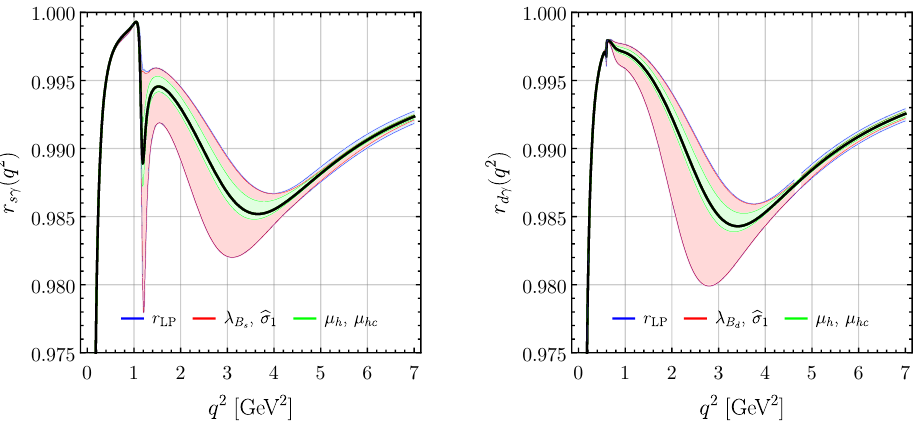
Figure 12 . The ratio r qγ for B s → γ‘ ¯ ‘ [left] and B d → γ‘ ¯ ‘ [right] with uncertainty budget as in figure